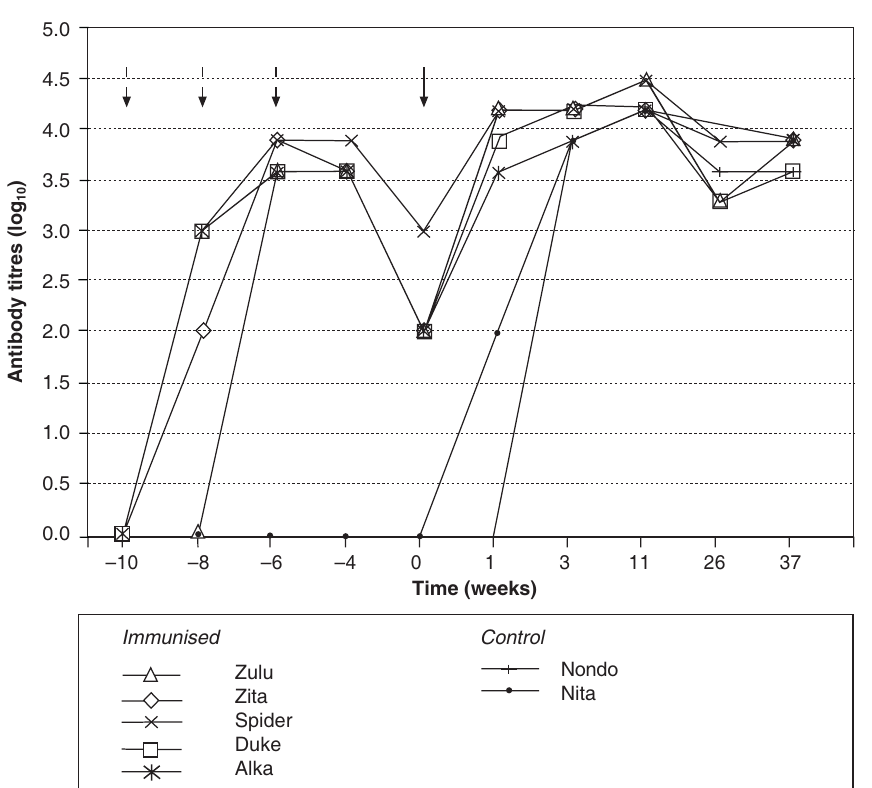
FIG. 1B Western blots to demonstrate the rise in E. canis spe- cific antibody titres in the sera of the two control dogs, Nita and Nondo, and the five immunized dogs, Alka, Duke, Spider, Zita, Zulu, 37 weeks post-challenge. Lane 1, negative control; Lane 2, positive control. The five lanes for the two control and immunized dogs show serum reactions at dilutions of 1/100, 1/1 000, 1/2 000, 1/4 000 and 1/8 000. Molecular mas markers